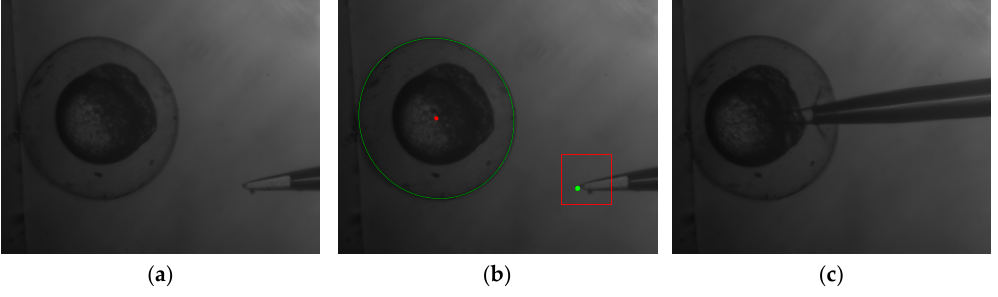
Figure 12. Images of automatic microinjection procedure: ( a ) embryo after autofocus; ( b ) detection of the embryo and pipette tip; and ( c ) embryo after injection.